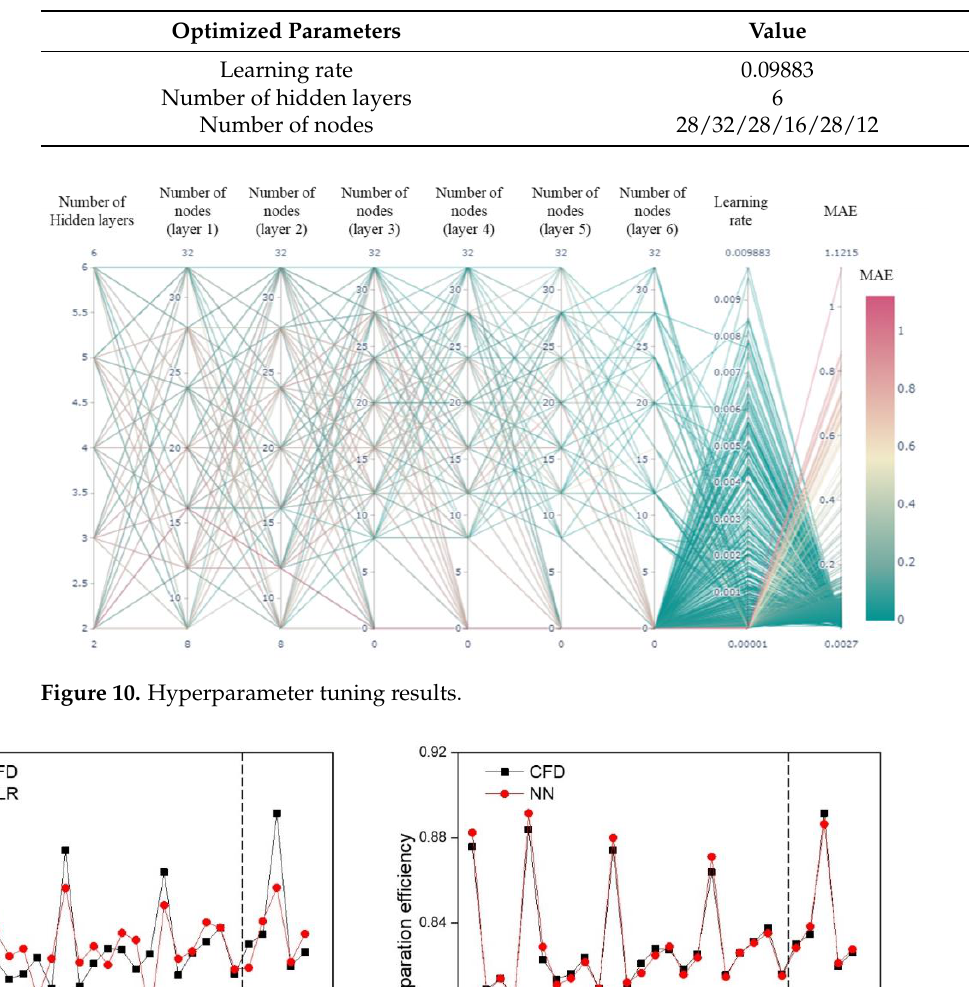
Table 4. The optimized hyperparameters.